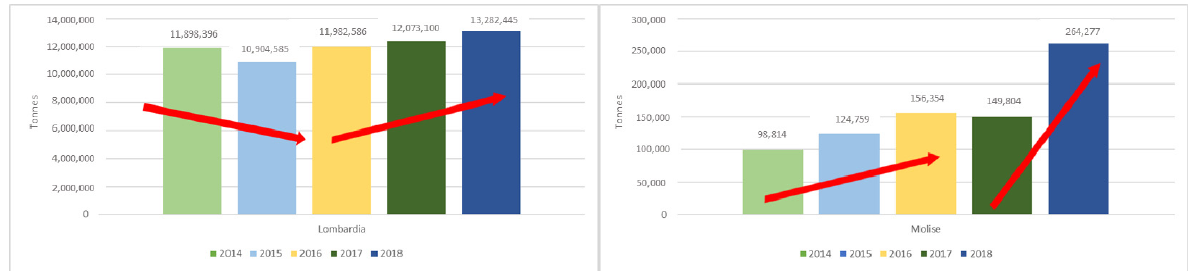
Figure 8. C&D waste production behaviour in the region of Lombardia and Molise. Source: Own elaboration with ISPRA data.